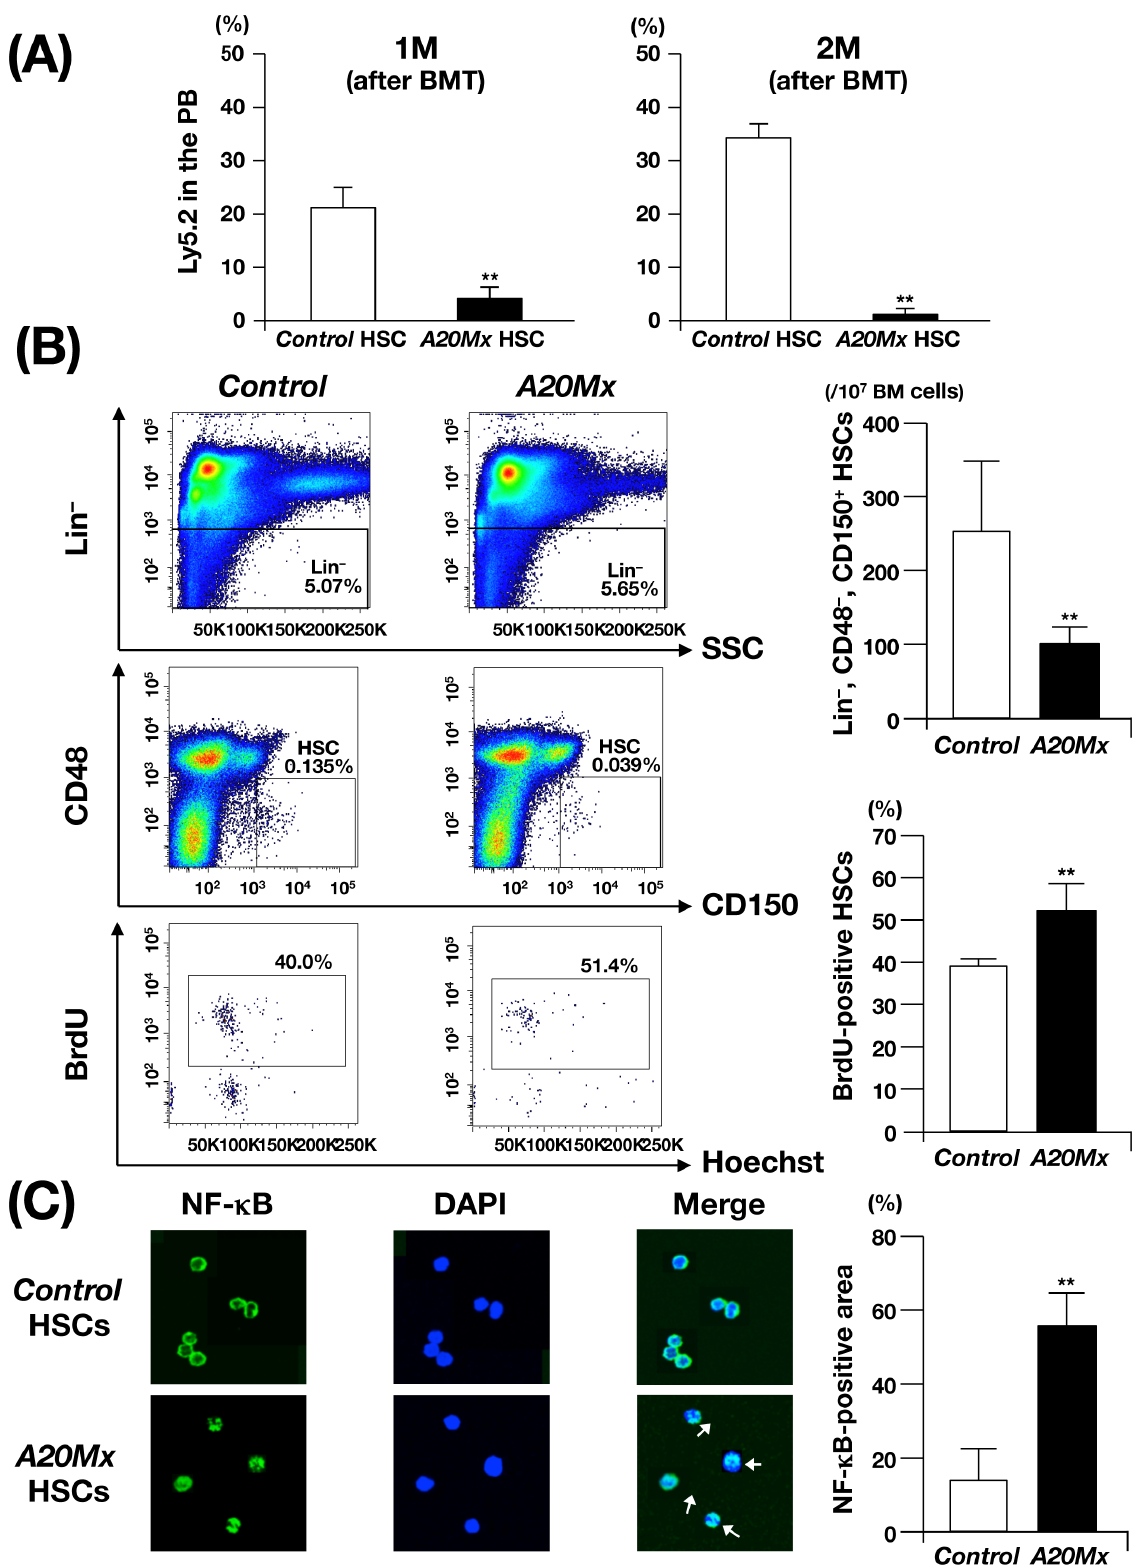
Figure 3. Analysis of HSCs in control and A20Mx mice. (A) The percentages of Ly5.2 + cells in the PB of control and A20Mx BMT mice at 1 and 2 months after BMT are shown. **p , 0.01 (Student’s t -test). (B) Cell number and BrdU incorporation in control and A20Mx HSCs. Representative results of flow cytometry is shown in the left panels and the HSC number and percentage of BrdU-positive cells are shown in the right column. **p , 0.01 (Student’s t -test). (C) Intracellular localization of NF- k B in control and A20Mx HSCs. Immunofluorescence staining of NF- k B and percentages of the NF-